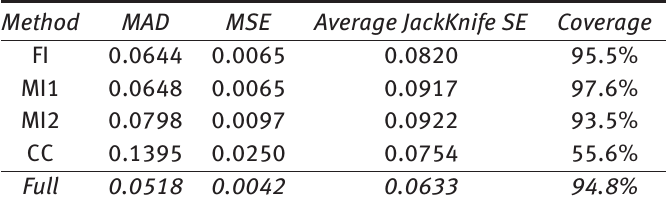
Table 3: Mean, Coverage, and Execution Results by Method: AIPW Results